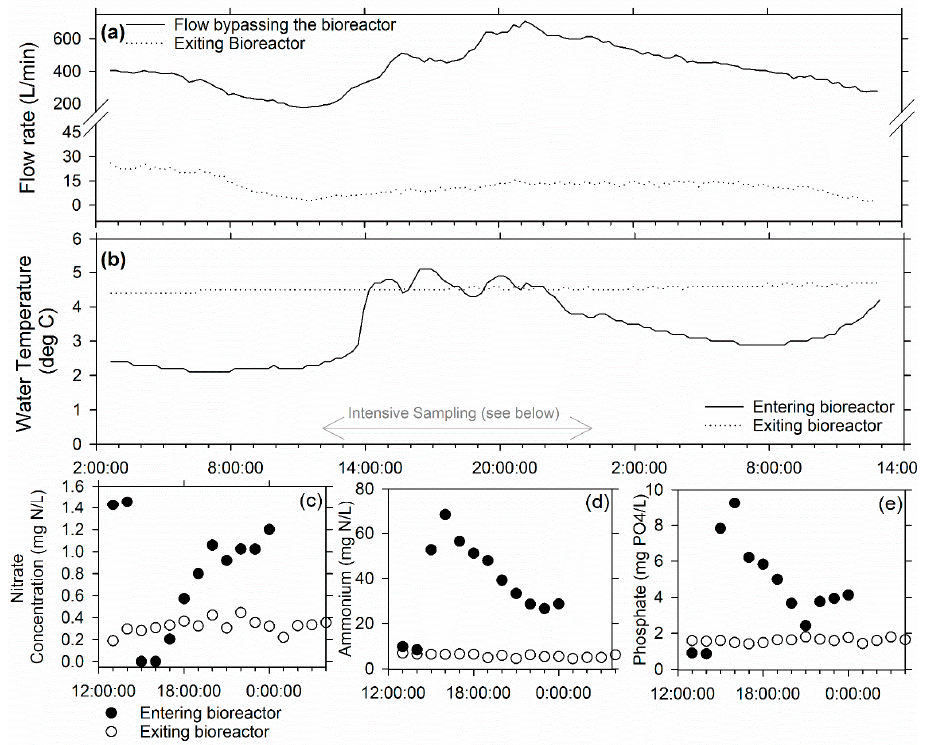
Figure 5. Ridgely Farm bioreactor drainage event 10–11 March 2015 flow rate ( a ); water temperature ( b ); and nitrate ( c ); ammonium ( d ); and phosphate ( e )